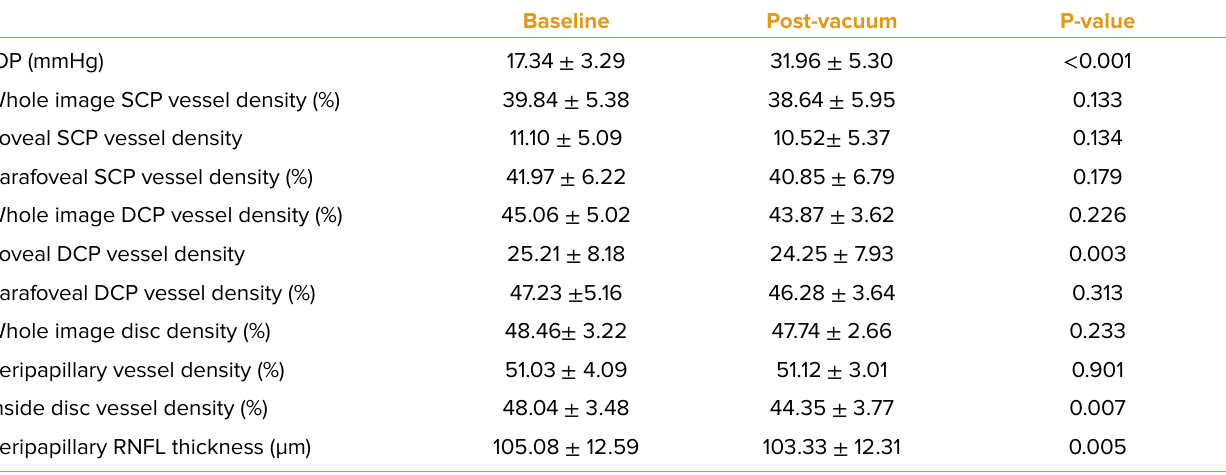
Table 3. Baseline and post-suction measurements in eyes with nonproliferative diabetic retinopathy.